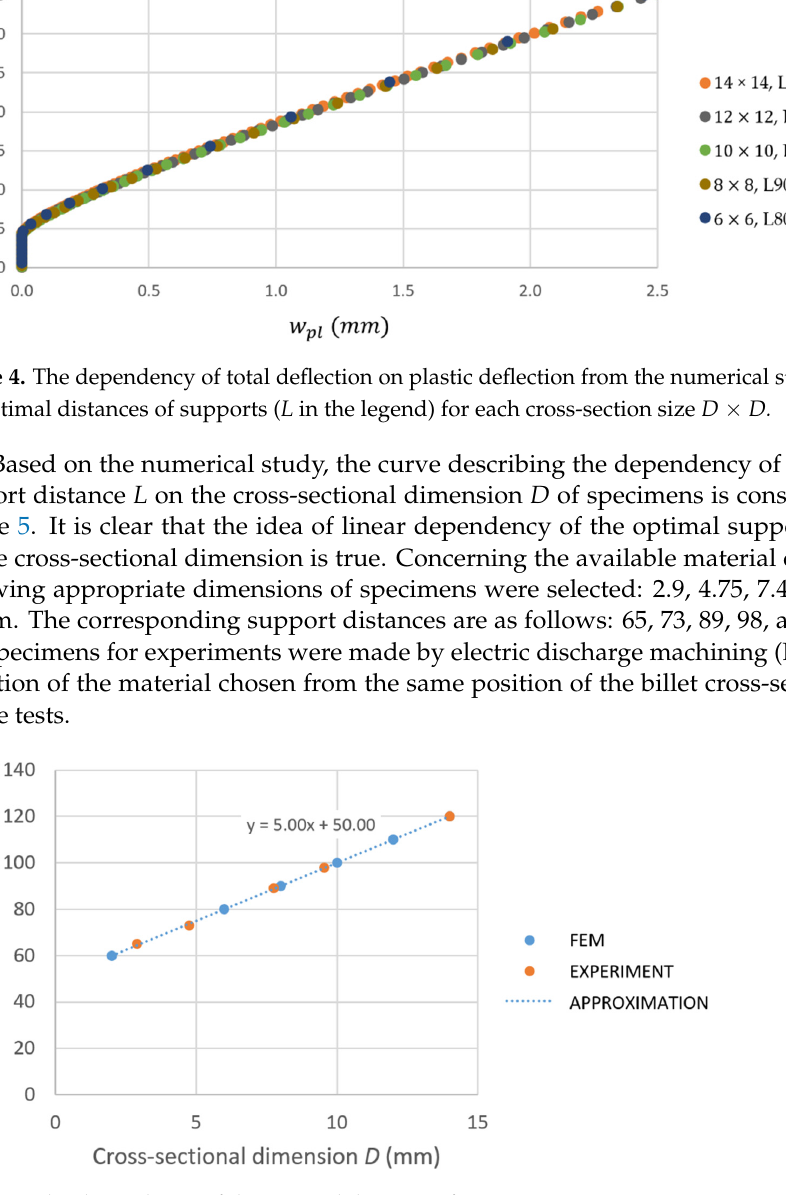
( b ) Figure 6. Photos from the three-point bending test: the whole setup ( a ) and selected deformed specimens ( b ). Obtained bending force versus total deflection diagrams are shown in Figure 7. The target total deflection (position of crossbar) was 3 mm for D = 2.9, 5 mm for D = 14, and 4 mm for all others.